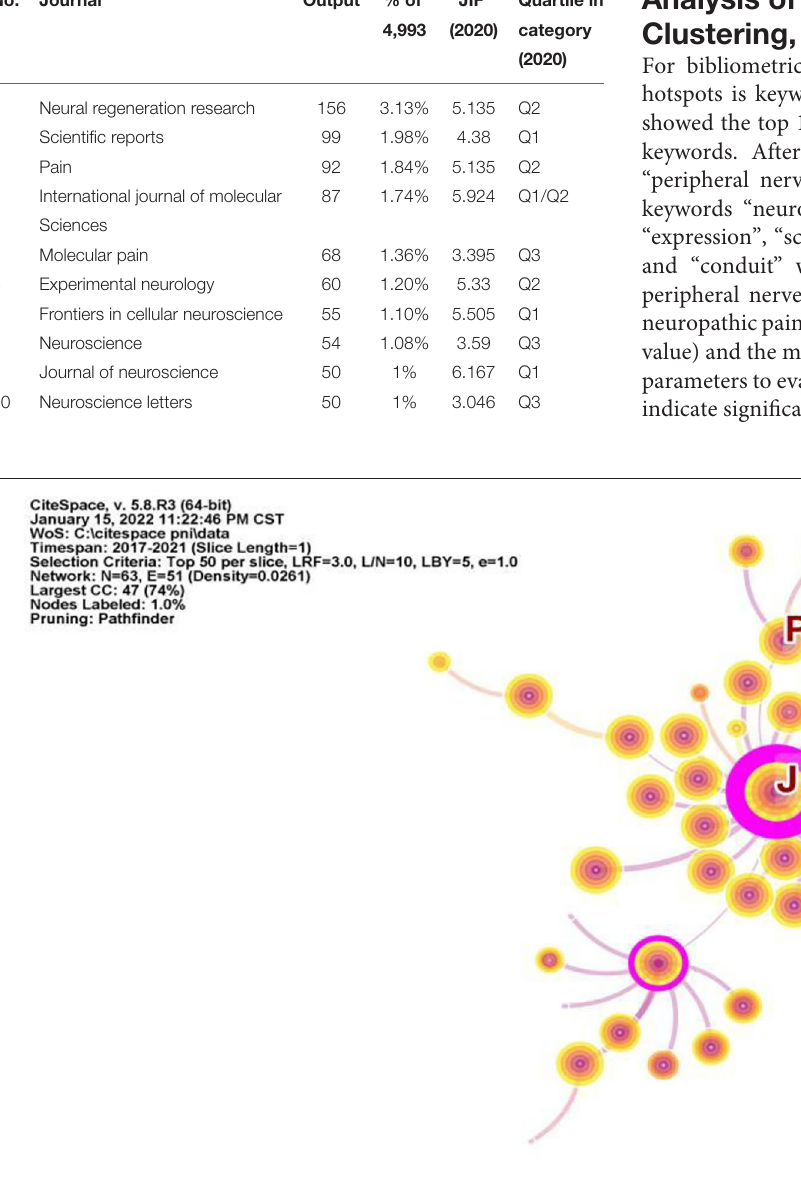
FIGURE 5 | Visualization map of journal co-citation analysis by using CiteSpace software.